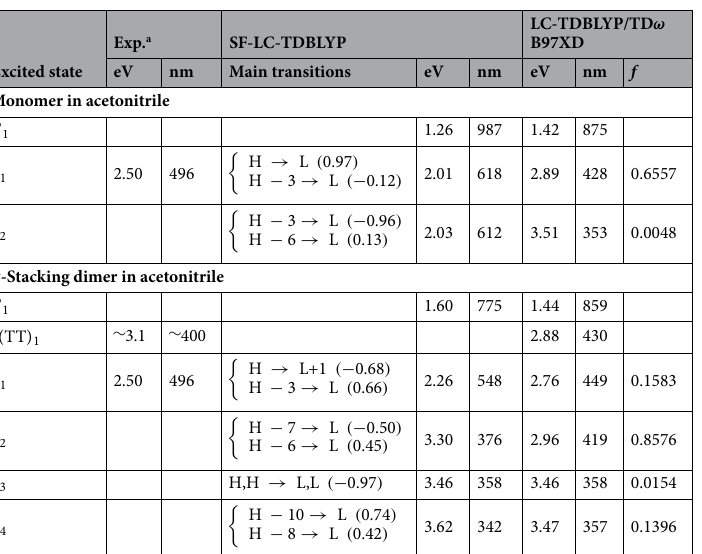
Table 2. Calculated vertical excitation energies (eV) of TMBODIPY derivative (b) for the monomer and π -stacking dimer by SF-LC-TDBLYP, LC-TDBLYP (monomer) and TD ω B97XD (dimer) with cc-pVTZ basis sets and CPCM solvent effect of acetonitrile. a Ref. 12 . Main transitions of SF-LC-TDBLYP excitations are also shown with the coefficients of the response functions in parentheses, in which the notations H and L indicate HOMO and LUMO. The oscillator strengths ( f ) of LC-TDBLYP (monomer) and TD ω B97XD (dimer) are also